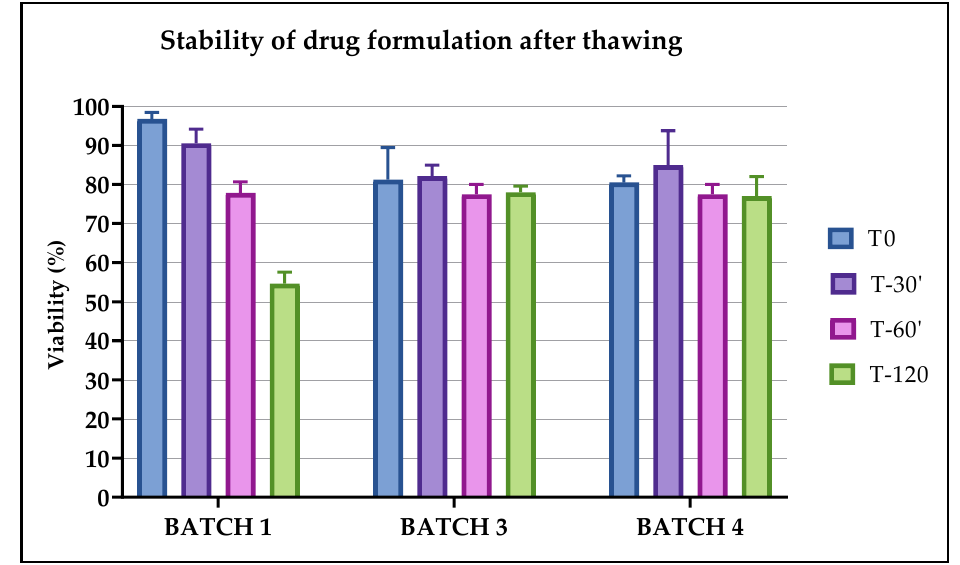
Figure 5. Viability of Batches 1, 2, 3 and 4 was evaluated to validate the stability of the cellular product after thawing. The percentage of viable cells was calculated for the bags thawed at 15 days post freezing (T0) and after 30 (T-30′), 60 (T-60′) and 120 (T-120′) min from the moment of thawing.